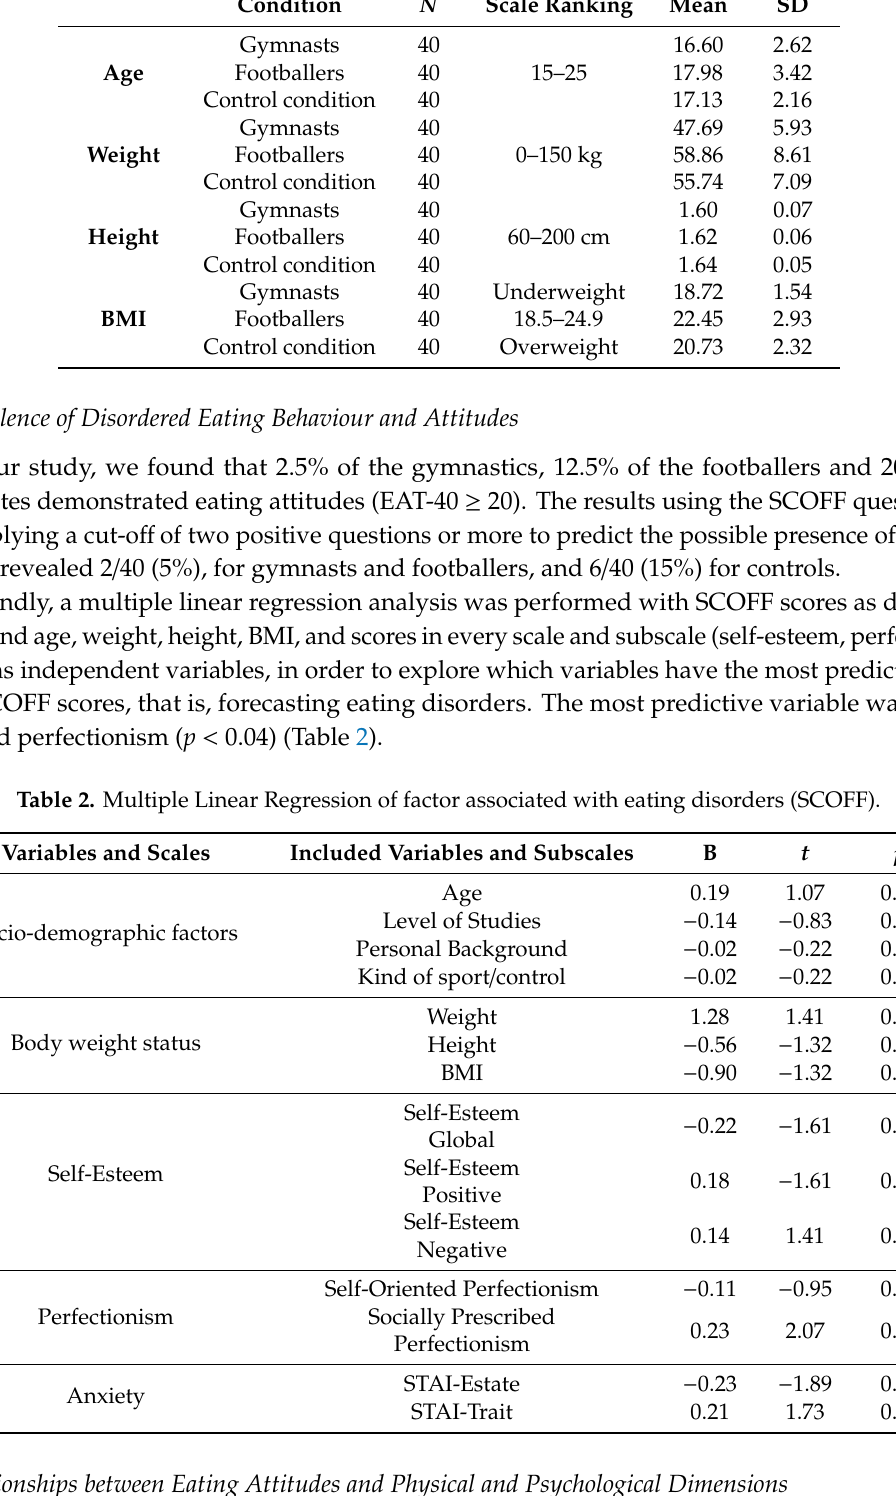
Table 1. Mean and standard deviation (SD) of the main physical variables (age, weigh, height and BMI (Body-Mass Index).